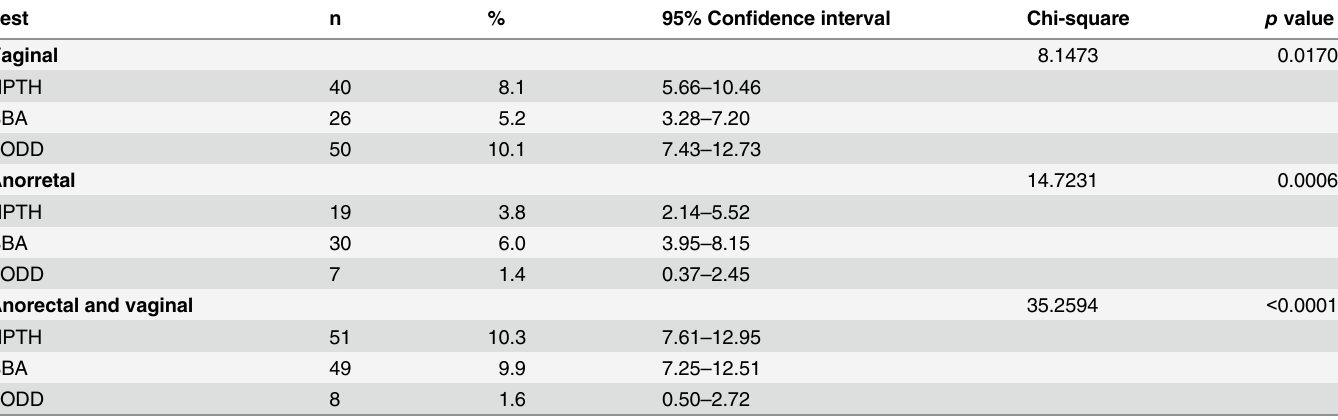
Table 1. Prevalence of Streptococcus agalactiae in pregnant women at 35 – 37 weeks of gestation, based on clinical specimens tested with Todd- Hewitt enrichment broth (TODD), sheep blood agar (SBA), and Hitchens-Pike-Todd-Hewitt (HPTH) culture